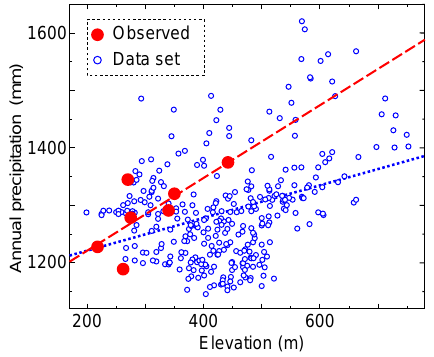
Figure A1. Altitudinal distribution of precipitation (HAZ catch- ment,